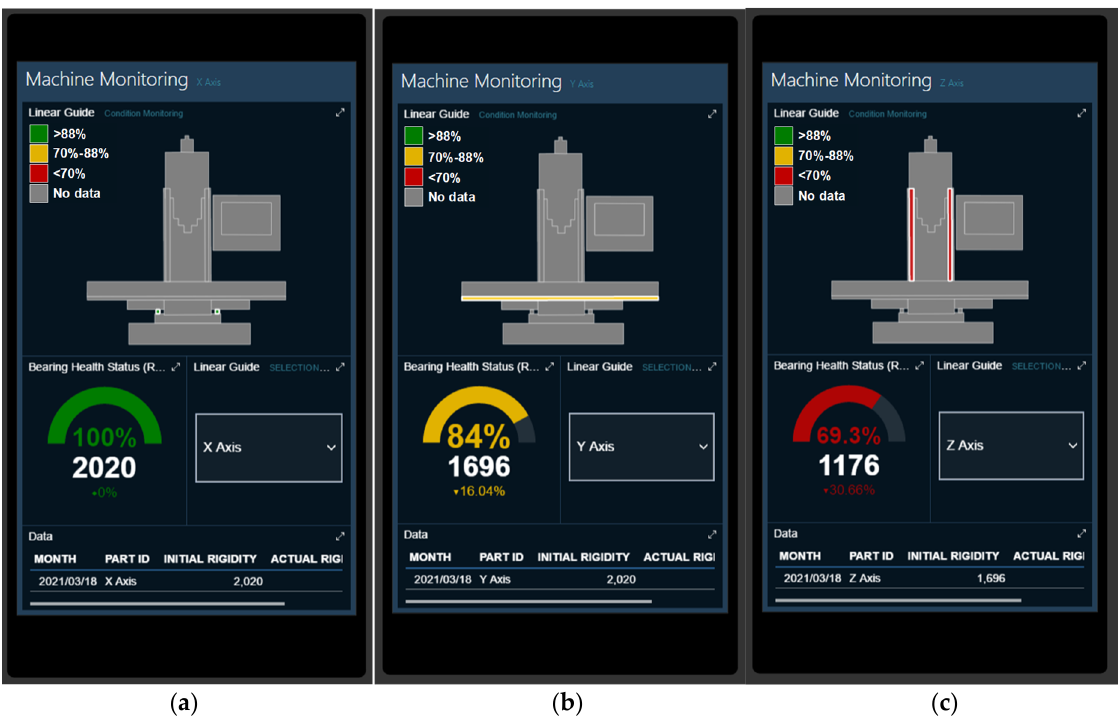
Figure 17. Application scenarios of predictive model with graphical user interface for monitoring rigidity decay of feeding mechanisms in milling machine: ( a ) X axis linear guide; ( b ) Y axis linear guide; and ( c ) Z axis linear guide.